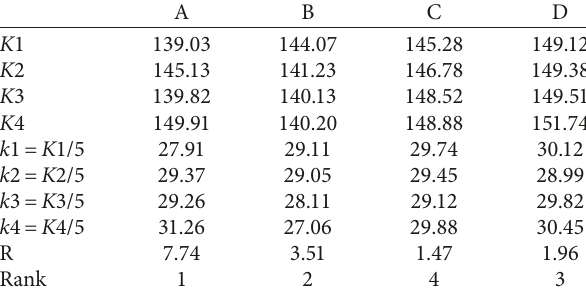
Figure 4: Finite element simulation model of automobile